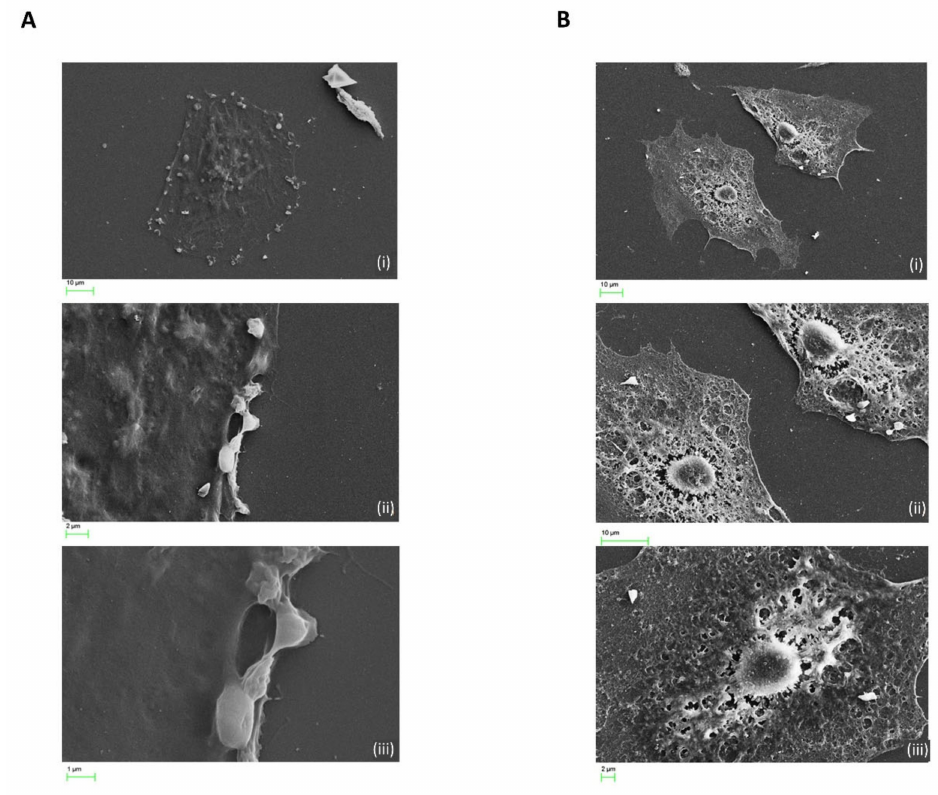
Figure 8. High dosages of cocaine results in microstructural deterioration of cardiomyocytes. ( A ) H9c2 cardiomyocytes treated with 5 µ g/mL cocaine. Treatment mediated retraction of cellular outgrowths with significant formation of surface and membrane blebs (i–iii). (iii) Discharge of formed bleb from the cell membrane. ( B ) H9c2 cardiomyocytes treated with 100 µ g/mL cocaine. (i–iii) Significant changes associated with injury involving cellular condensation and loss of architectural polarity and intercellular membrane extensions (ii), cell surface collapse, perforation, and cell nuclei separation (ii–iii). Scale bars for each panel are presented below the respective